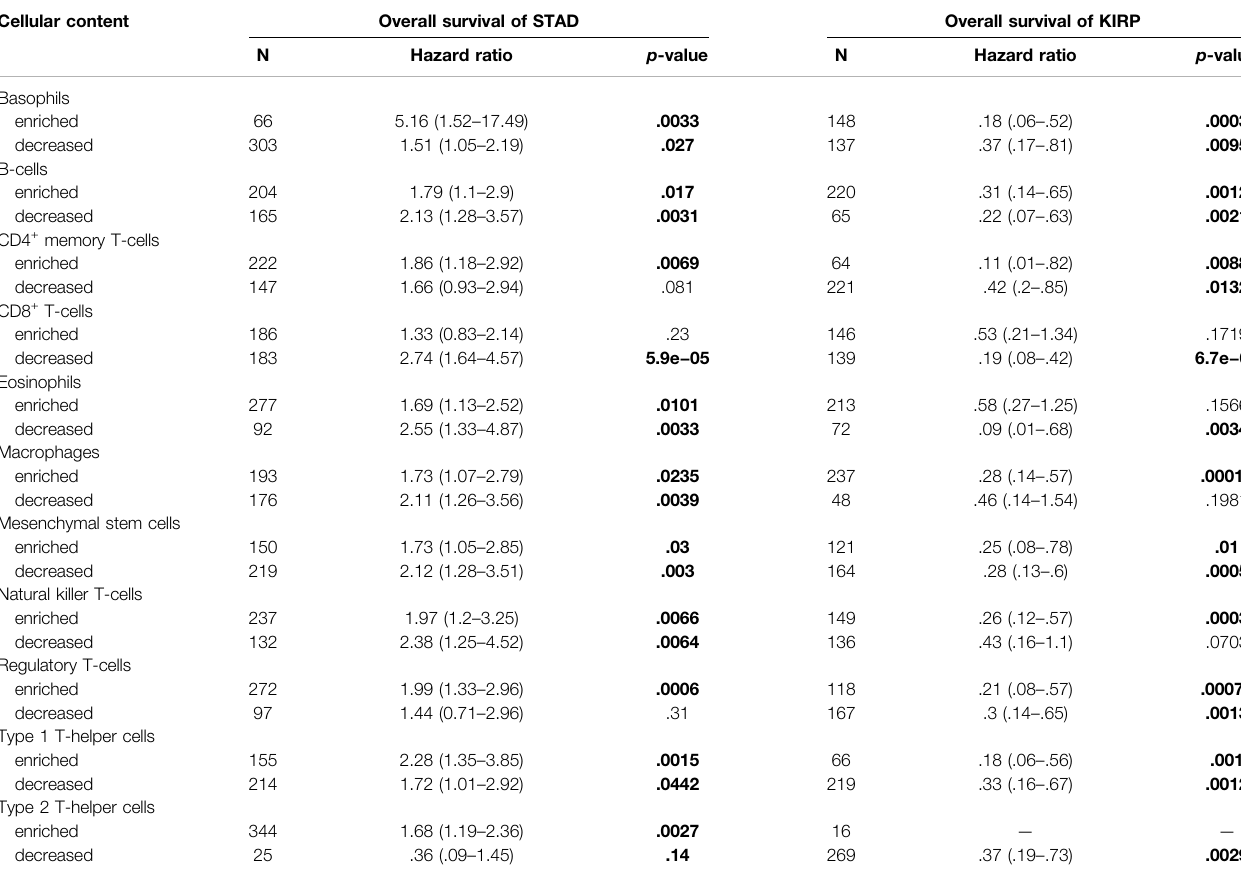
TABLE 2 | Correlation of VSTM2L expression and overall survival in STAD and KIRP according to the immune cell pro fi le using Kaplan-Meier plotter. Cellular content Overall survival of